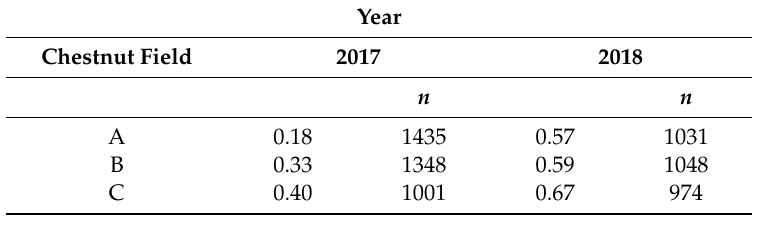
typologies (Table 2). The lowest parasitism rate was recorded during 2017 in all monitored fields (Table 3), with about half of all hosts parasitized, whereas the ratio was ≃ 0.8 in 2018 (Figure 1).